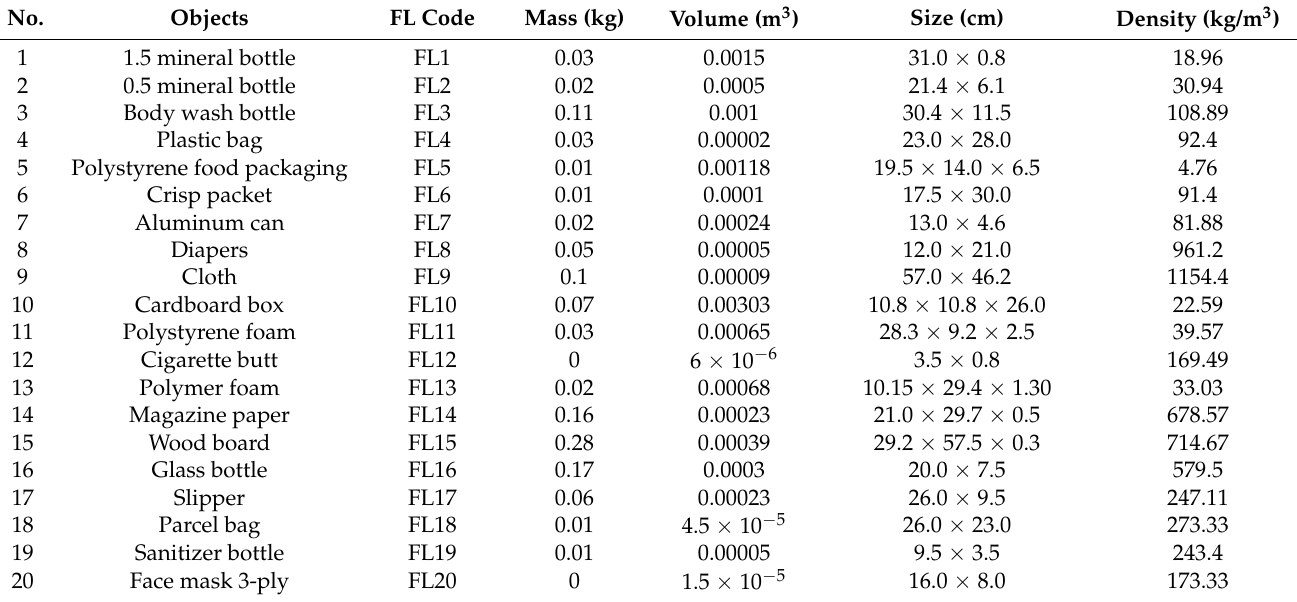
Table 2. Physical characteristic parameters of floatable